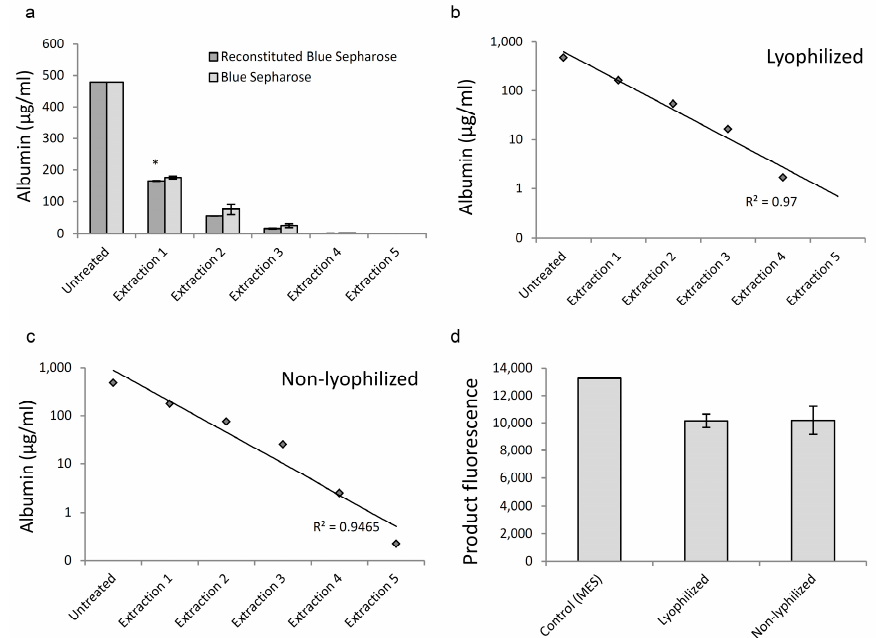
Figure 6. Ability of Blue Sepharose to deplete albumin is not reduced by lyophilization. ( a )—Decrease in albumin concentration after five cycles of extraction with lyophilized and non-lyophilized Blue Sepharose, n = 2, error bars = standard deviation, * p = 0.046; ( b , c )—Linear relationship between albumin concentration and extractions; ( d )—Albumin depleted buffer was used in the cleavage of CDG-3 by BlaC (404 nM). n = 2 (experimental replicates), error bars = standard deviation.